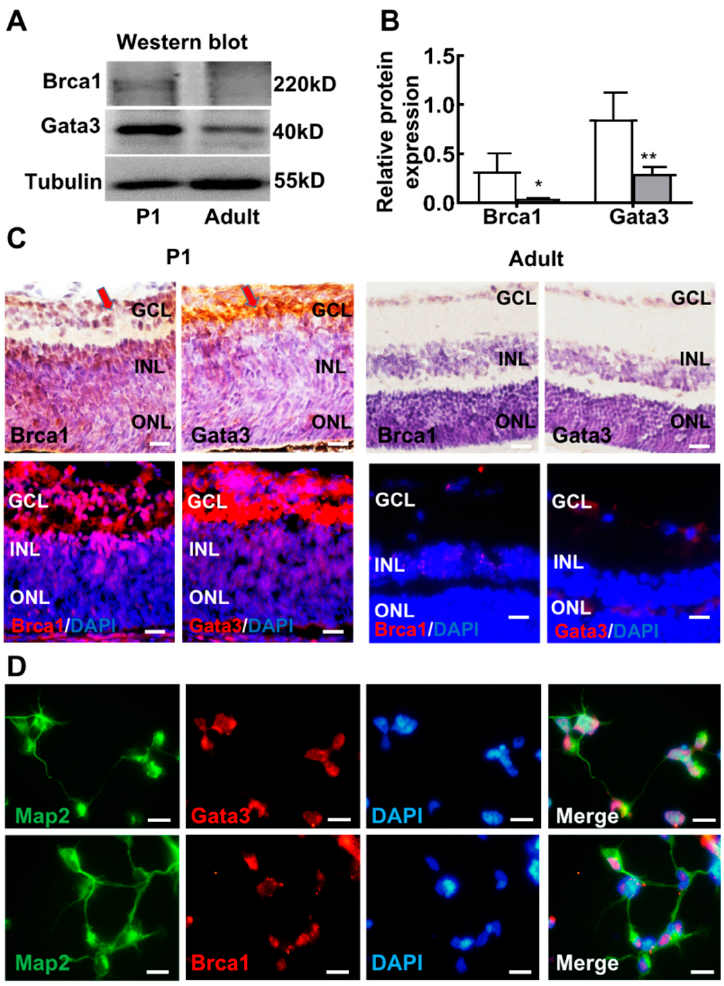
Figure 6. The expression profile of Gata3 generally parallels that of Brca1 in the retina. ( A ) Both Gata3 and Brca1 are developmentally downregulated in the mouse retina in vivo, as evidenced by Western blot. ( B ) The relative protein expression levels of Gata3 and Brca1 are presented as histograms. ( C ) The expression and localization profiles of Gata3 are coincident with that of Brca1 in the mouse retina, as evidenced by immunohistochemistry and immunofluorescence assays, Gata3 and Brca1 were stained as red in immunofluorescence. ( D ) Map2 (green, cell cytoplasm) marks neurons, both Brca1 (above, red, cell nuclei) and Gata3 (below, red, cell nuclei) were expressed in P1 retinal neurons. Scale bars represent 20 μ m. The asterisks indicate statistically significant differences (* p < 0.05, ** p < 0.01).